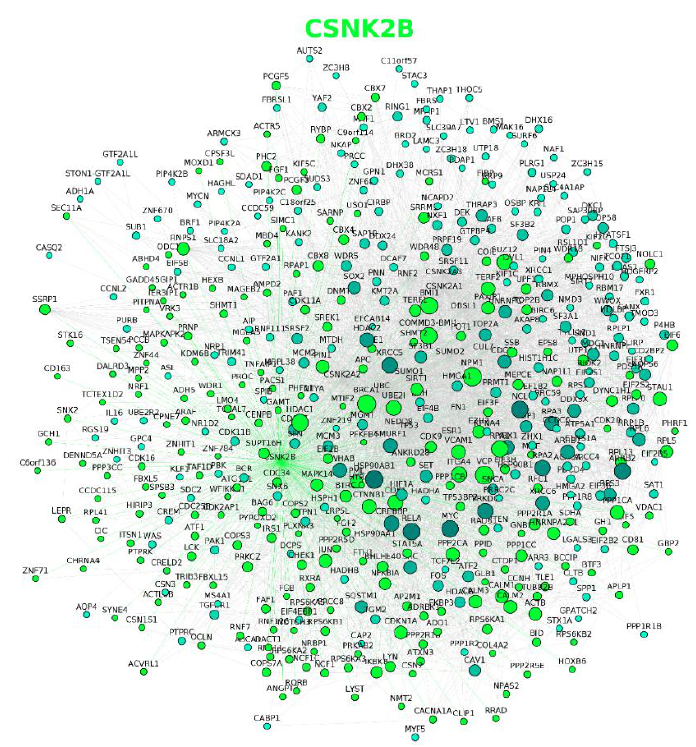
Figure 2. Protein–protein interaction network of human CK2 subunits generated using Cytoscape v3.4.0 and the BisoGenet v3.0.0 plugin. The three networks are clones, each of which highlights the interactors of CSNK2A1 (red nodes), CSNK2A2 (orange nodes), and CSNK2B (green nodes) subunits, respectively. Briefly, the network was represented by querying SysBiomics (BisoGenet’s interaction database) through the plugin’s interface using the human CK2 subunit gene names and selecting “protein–protein interaction” as the biorelation type and the input nodes and neighbors to step 1 method as the criteria for building the network. A high resolution image of this figure is also available in the Supplementary Materials.